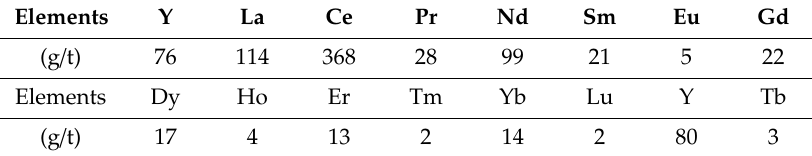
Table 4. Composition of rare earth elements in Greek red